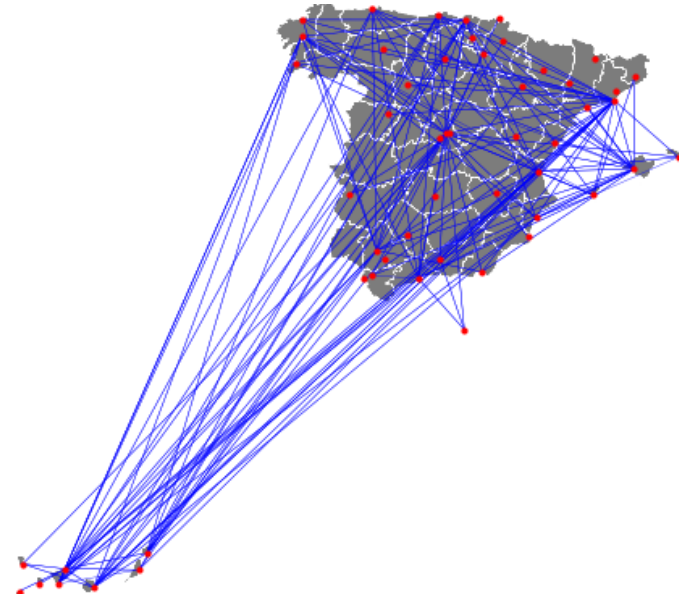
Figure 2. Airports and intersecting airways on the Mercator projection of Spain.